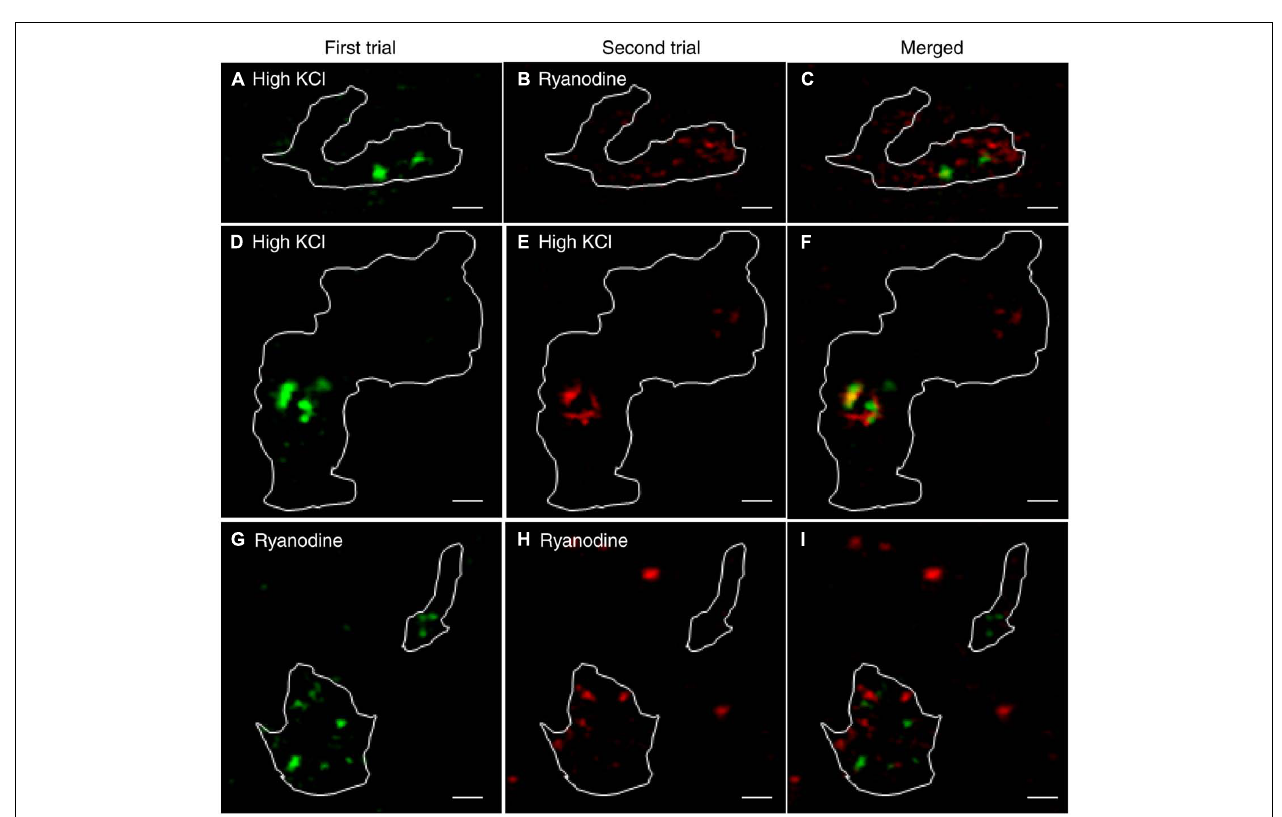
depolarizing the same rods with a 50-ms step from − 70 to − 10 mV to trigger influx through Ca 2 + channels clustered near ribbons. The difference image was generated by subtracting the average of 15 resting images before the step from an average of two test images during the 50-ms depolarizing test step. The overlaid image in (C) shows that sites of vesicle recruitment and release did not overlap with locations of ribbons shown by focal Ca 2 + entry sites. Scale bar: 1 μ m.